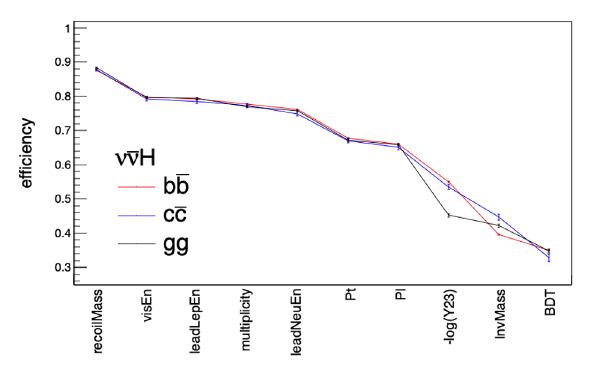
¯ b/c ¯ c/gg ) for each cut variable.